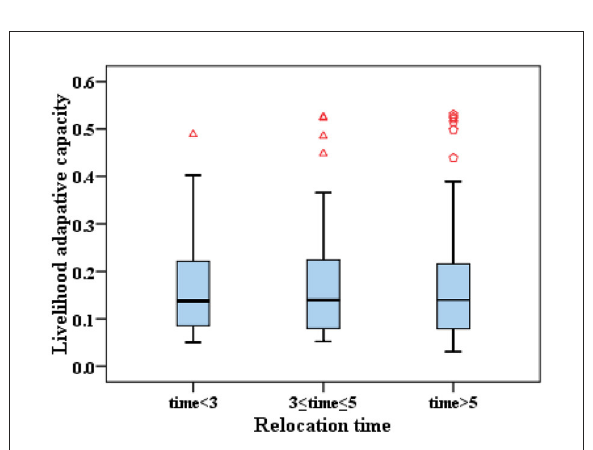
FIGURE2 The livelihood adaptive capacity index of different relocation